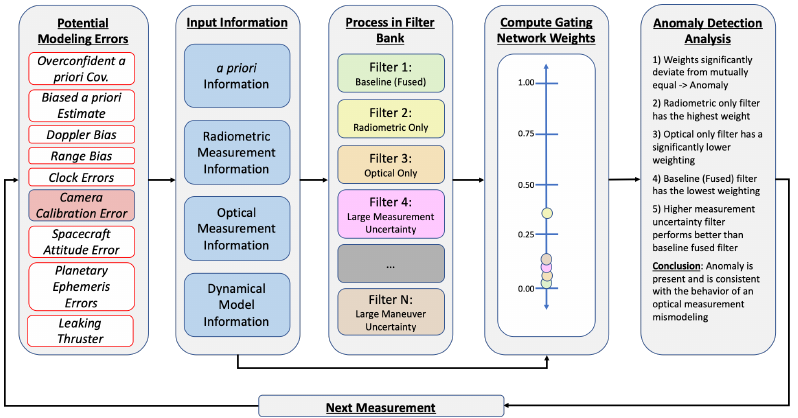
Figure 1. An overview of the anomaly detection and characterization process via filter bank gating network weights with example errors and filter